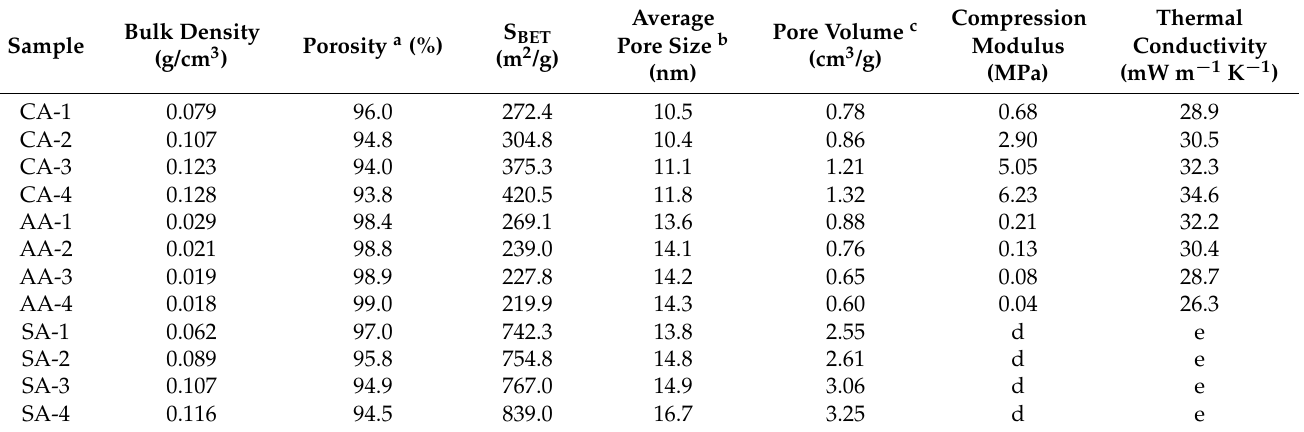
Figure 4. ( a ) N 2 adsorption–desorption isotherms and ( b ) BJH pore size distributions of the CAs samples. Table 1. Physical properties of composite aerogels (CAs), agarose aerogels (AAs), and silica aerogels (SAs).